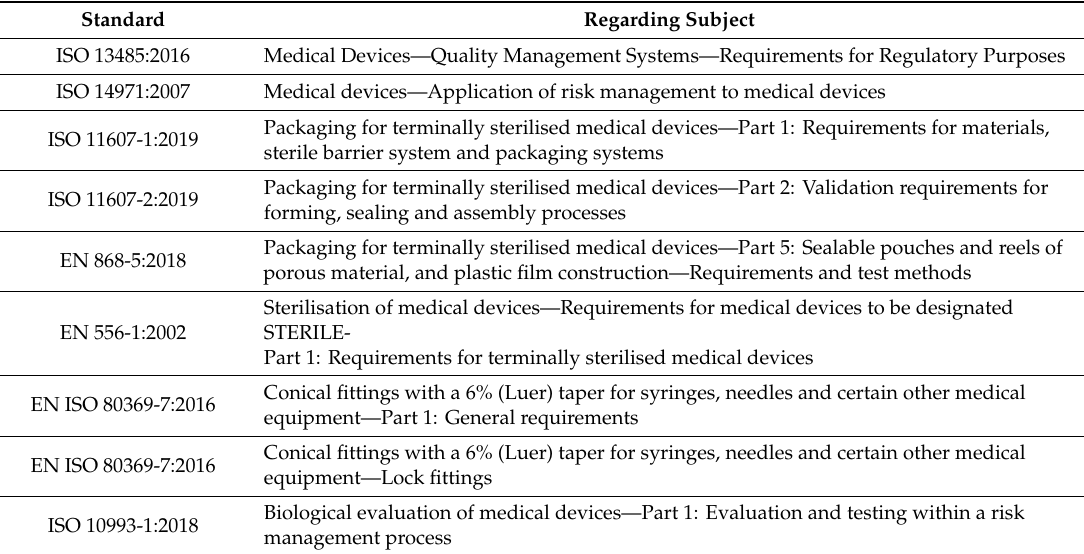
Table 2. Essential requirement